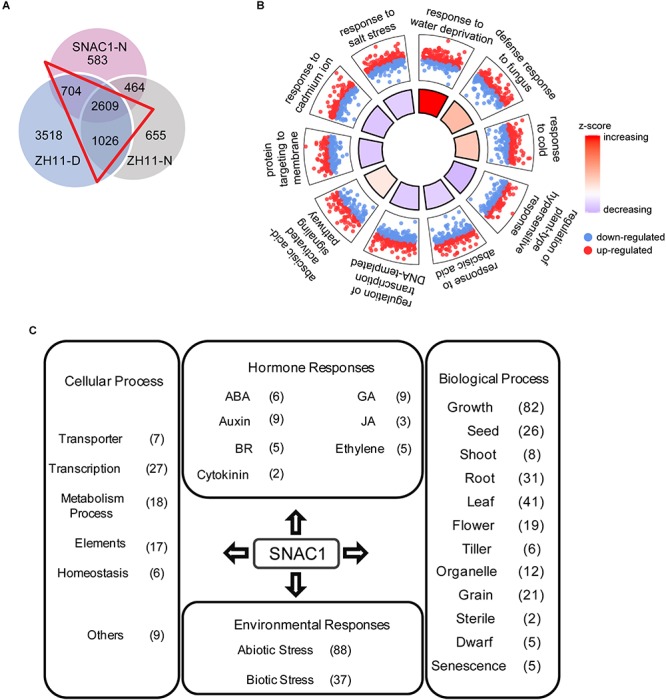
ChIP-Seq analysis of putative SNAC1-binding sites (genes). (A) Overlapping numbers of SNAC1-binding genes among the three samples: SNAC1-N, ZH11-D, and ZH11-N. The numbers in red triangle collectively represent the putative SNAC1-binding genes involved in drought response (SNAC1BGDs). (B) GO enrichment analysis on SNAC1BGDs. Top 10 significantly enriched GO terms in the biological processes category are shown. (C) SNAC1BGDs with known functions in various cellular processes and responses.